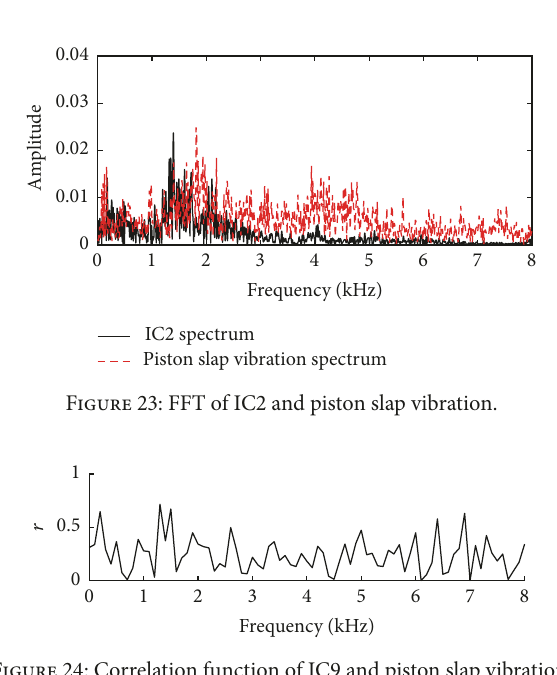
Figure 24: Correlation function of IC9 and piston slap